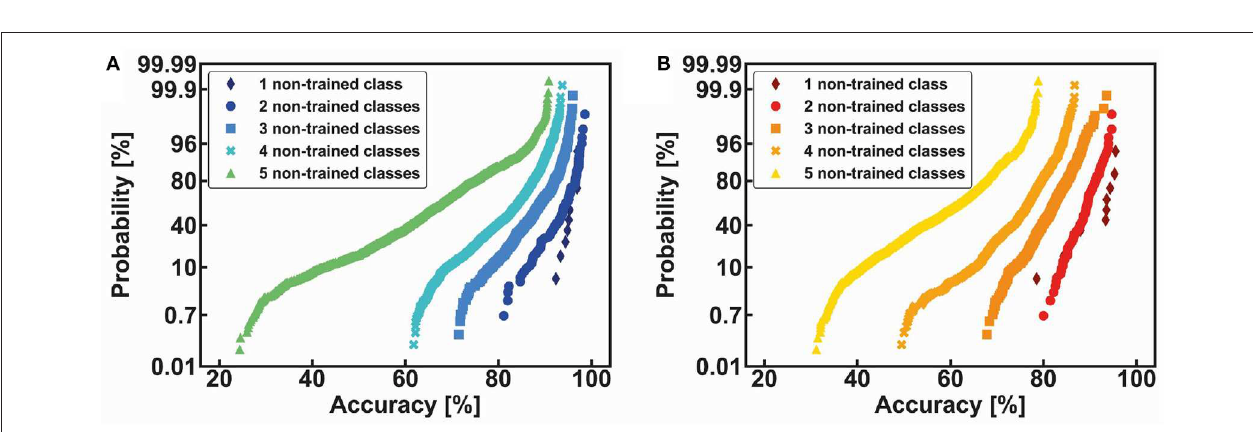
designed using a 90 nm node technology. The power required by convolution has been estimated in simulation taken into consideration the power for reading the PCM devices, the number of total steps required for performing the convolution